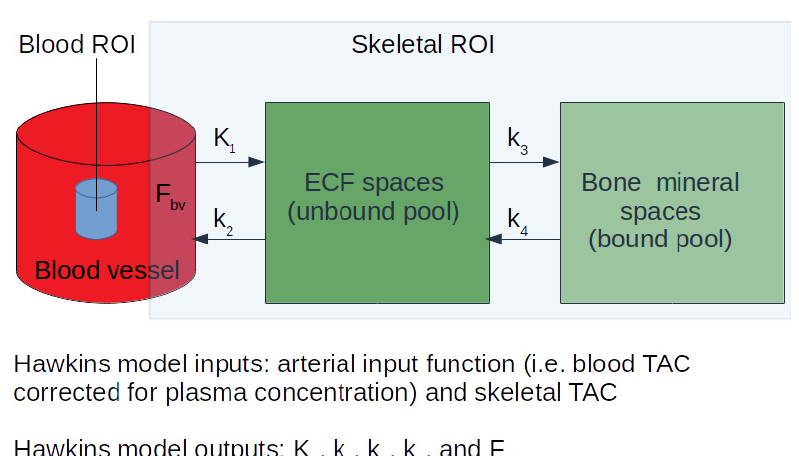
Figure 1. The two-tissue compartment Hawkins model was adapted from Hawkins et al. [33] and Azad et al. [34] to analyze bone studies using [ 18 F]NaF PET. K 1 (units: mL min − 1 mL − 1 ) describes the unidirectional clearance of fluoride from plasma to the whole of the bone tissue, k 2 (units: 1/min) describes the reverse transport of fluoride from the ECF compartment to plasma, k 3 and k 4 (units: 1/min) describe the forward and backward transportation of fluoride from the bone ECF to the bone mineral compartment. In order to account for vascular [ 18 F]NaF activity in the tissue region, a fifth parameter, fractional blood volume (F BV ) is also sometimes included in the model as the time–activity curves of skeletal region of interest include small parts of blood vessels. PET = positron emission tomography; ECF = extracellular fluid.